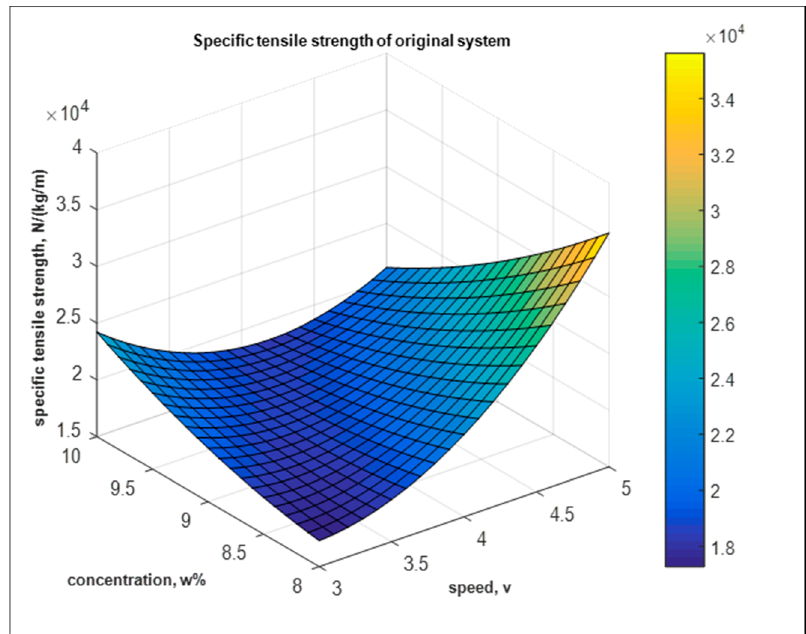
Figure 22. Fitted model of the specific tensile strength from the original system.